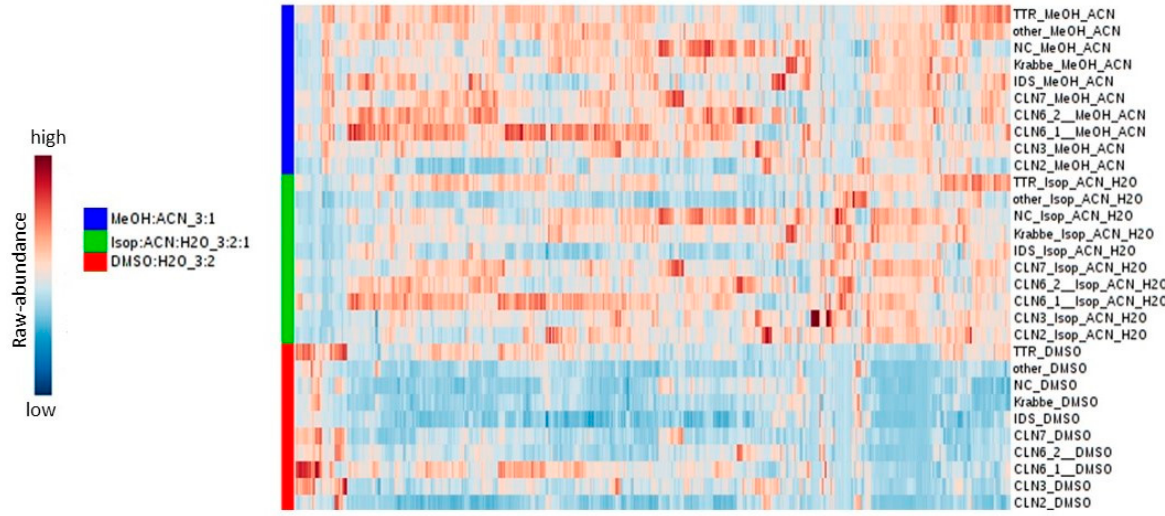
Figure 7. Heatmap showing the reproducibility of the extraction procedure.